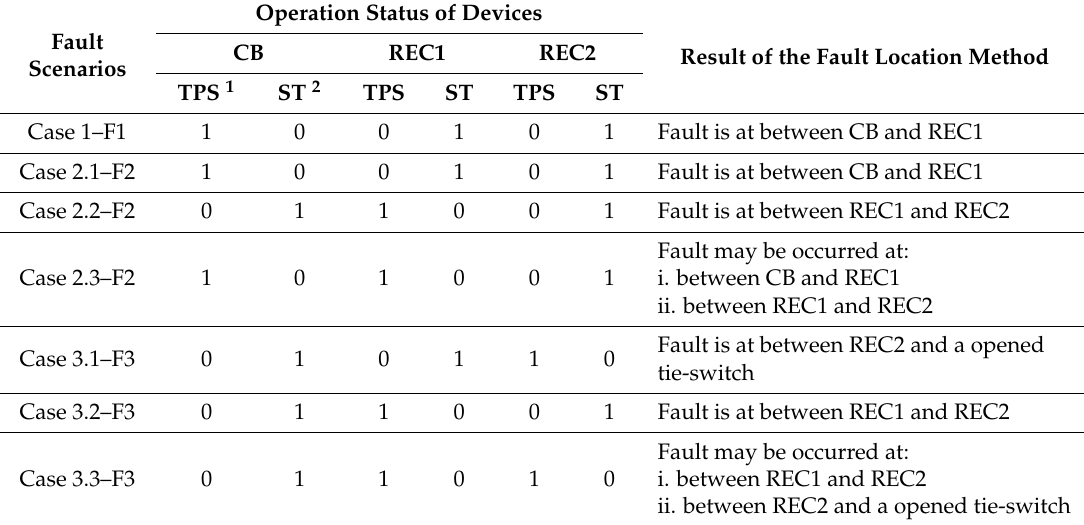
Table 2. The fault location method using the TPS with respect to different fault